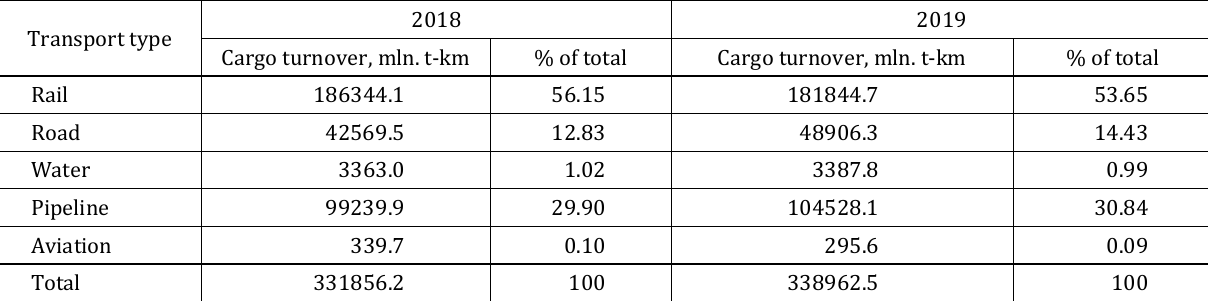
Table 3. Ukrainian cargo turnover for 2018-2019 by modes of